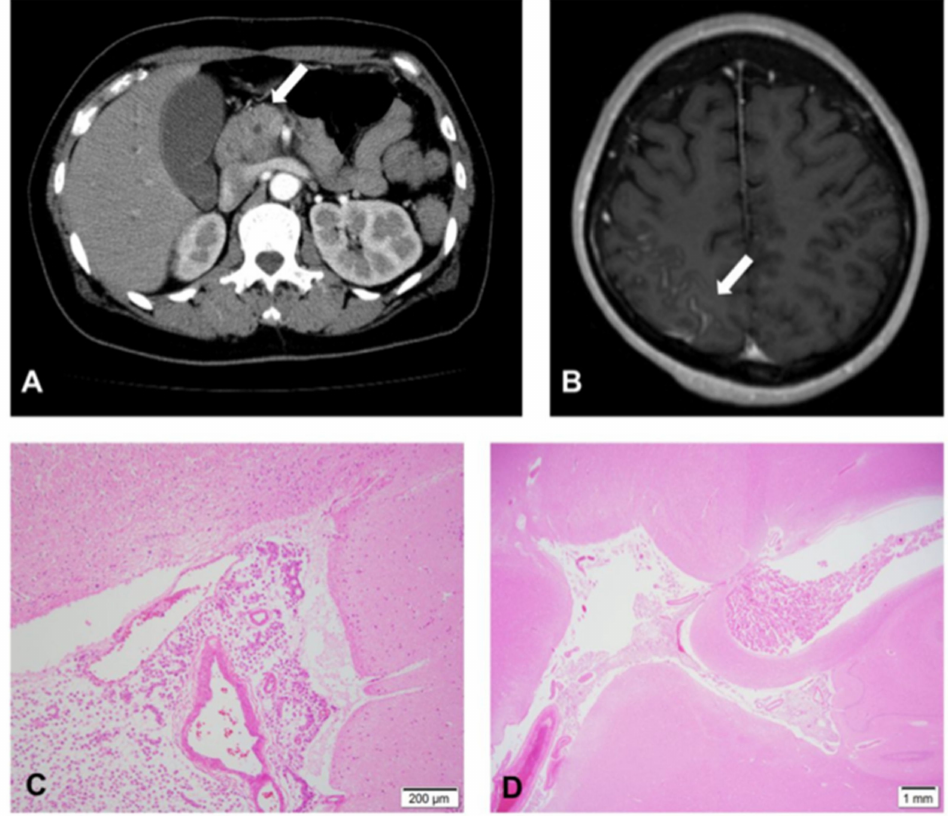
Figure 1. Characteristics of the pancreatic cancer case and associated leptomeningeal carcinomatosis. ( A ) Computed tomography of the abdomen showing the primary site of the pancreatic tumor, as indicated by the arrow. ( B ) Axial contrast-enhanced T1-weighted magnetic resonance imaging showing tumor cells infiltrating the sulci of the right parietal lobe. ( C , D ) Hematoxylin-eosin-stained histopathologic specimens obtained during autopsy showing a thin layer of infiltrated meninges surrounding the